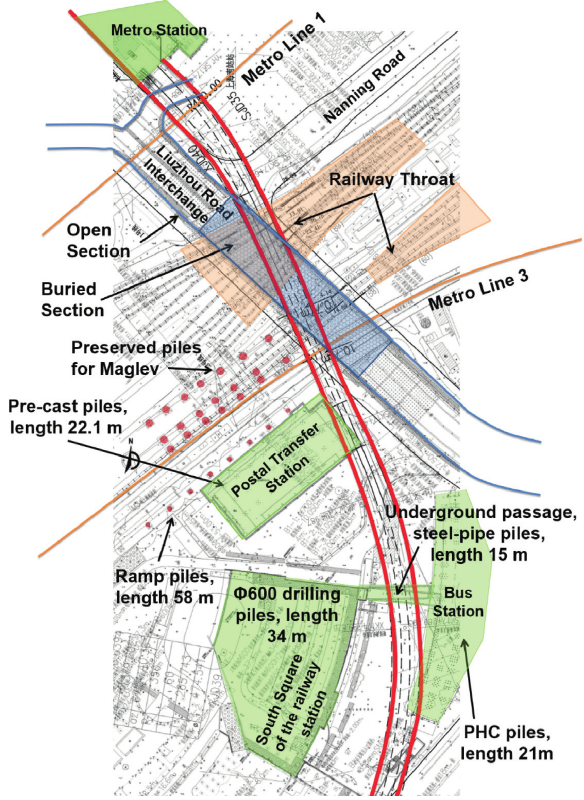
Figure 3: Plan view of the construction constraints and selected line